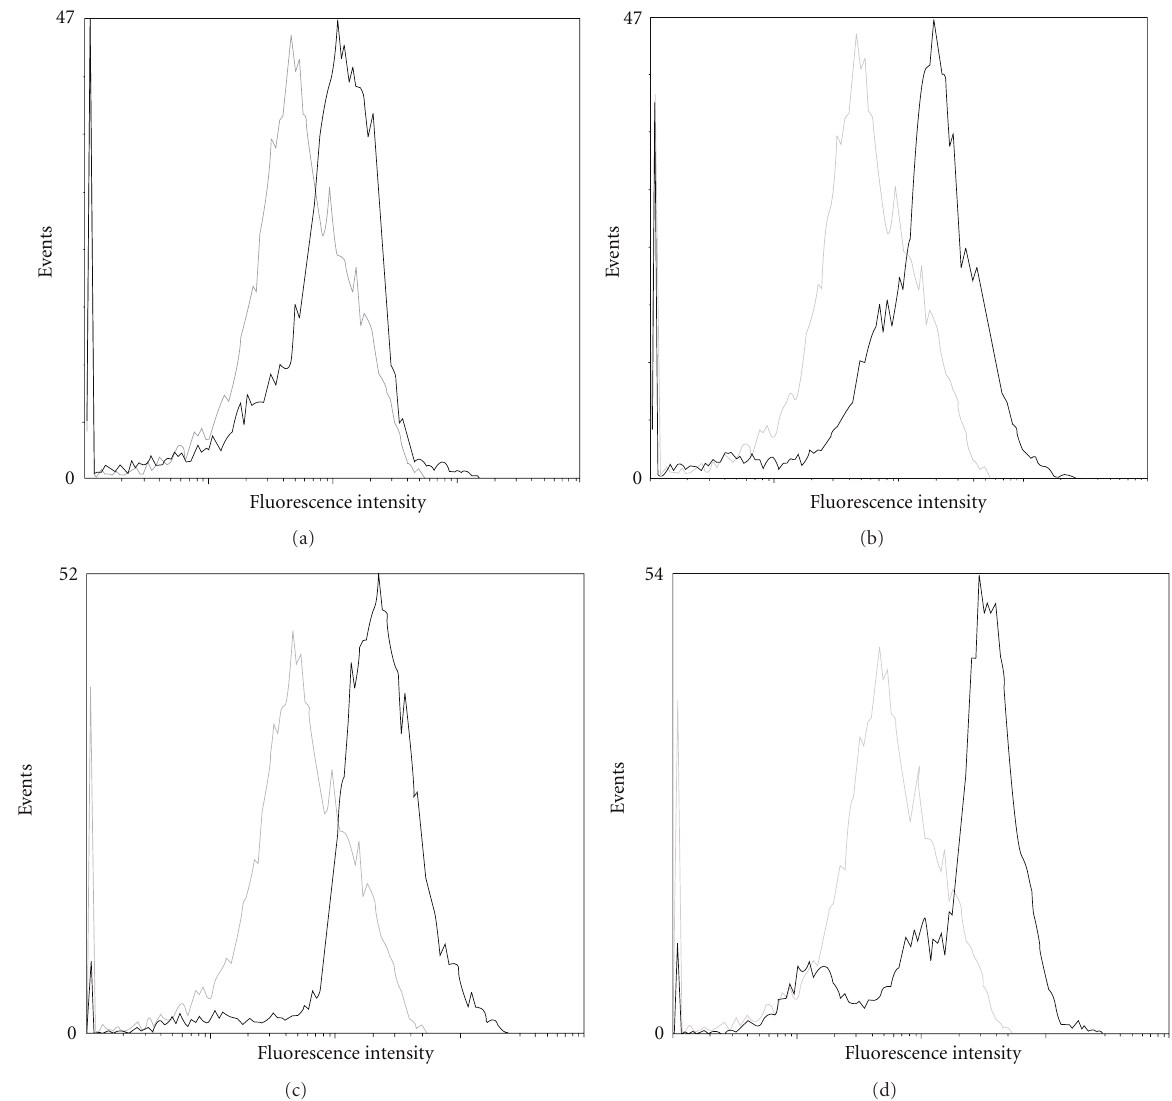
Figure 4: Rho123 accumulations in CD8 + cells ex vivo , where the grey lines stand for cells treated with Rho123 plus the vehicle and it was set as the control in the four sub-figures and the black lines represent cells treated with Rho123 in the presence of various concentrations reversors: A. VER 5.0 μ M, B. CH 2.5 μ M, C. CH 5.0 μ M, D. CH 10.0 μ M. This figure is representative of at least four independent